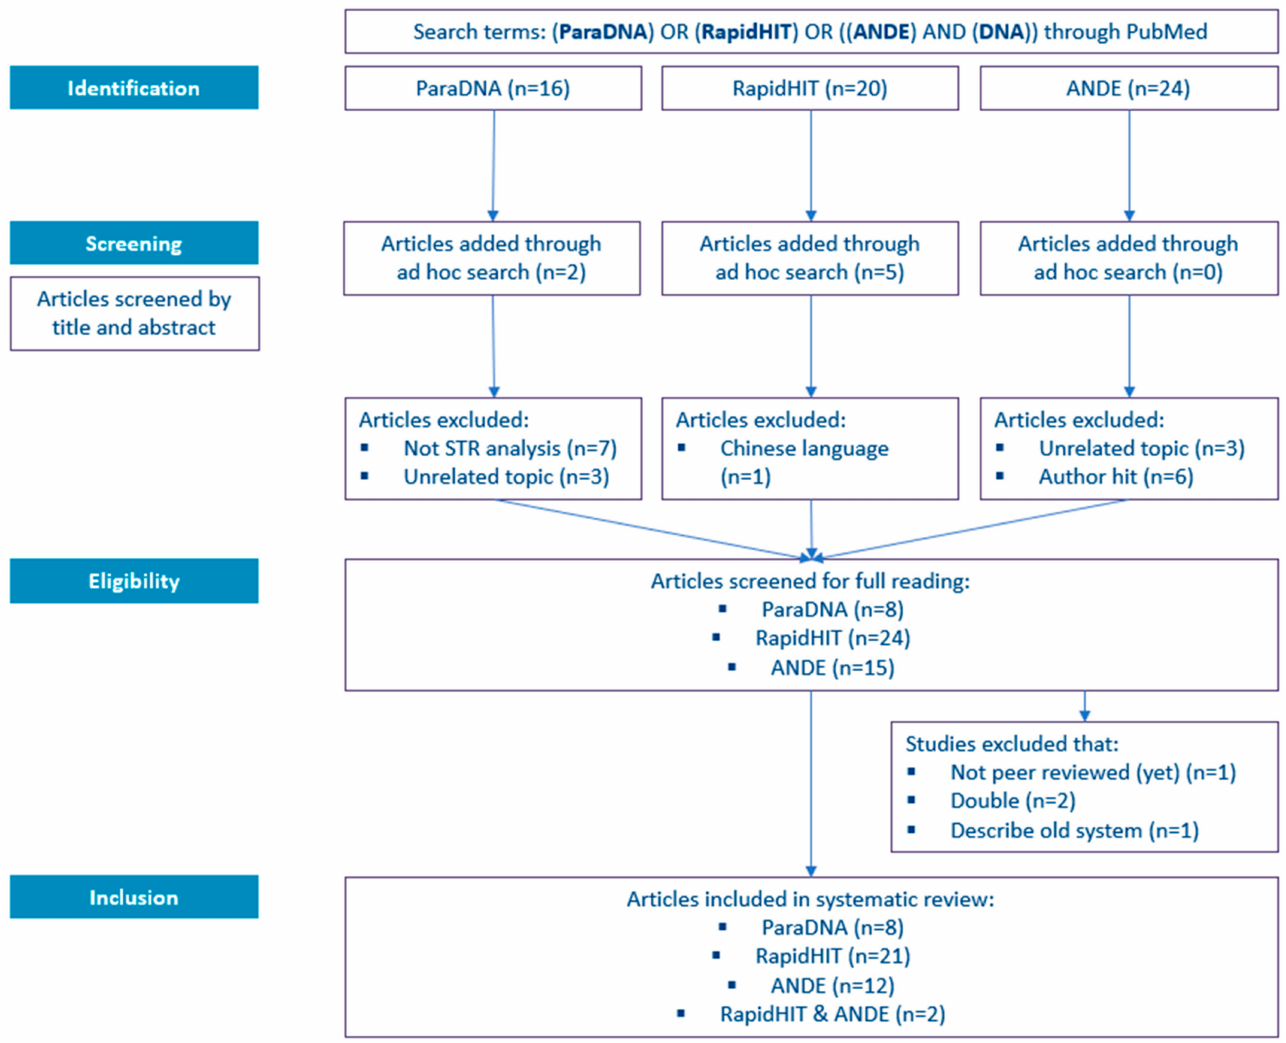
Figure 2. The PRISMA flow diagram was used in this systematic